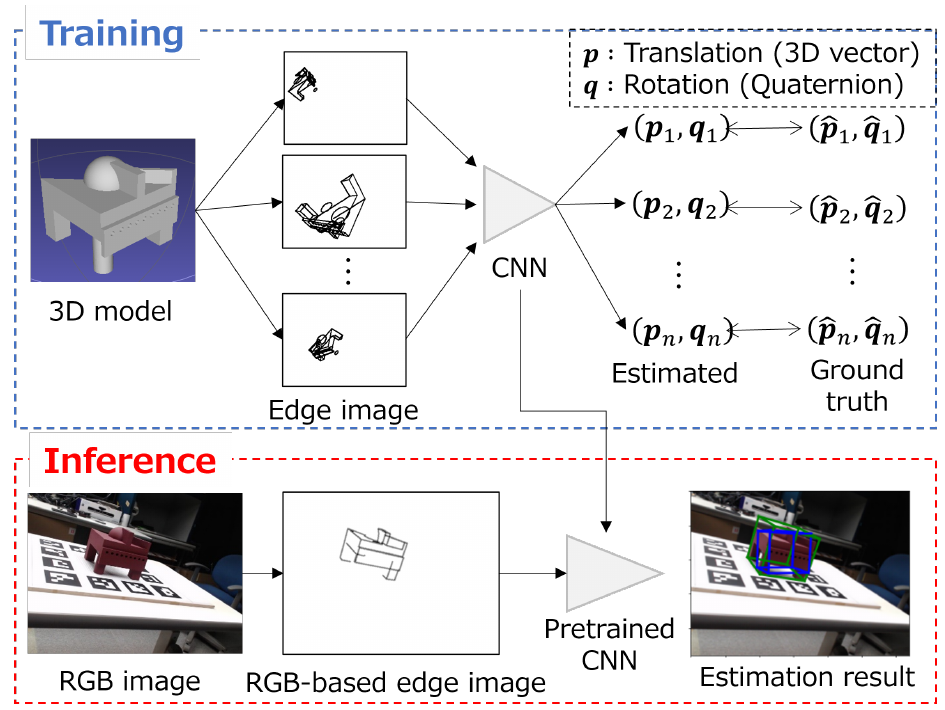
Figure 1. Overview of our method. Firstly, an edge image is randomly created by using the 3D model. The CNN model is trained with the generated dataset. At the inference stage, an RGB-based edge image is generated from an RGB image. Finally, the RGB-based edge image is input to pre-trained CNN and the pose is